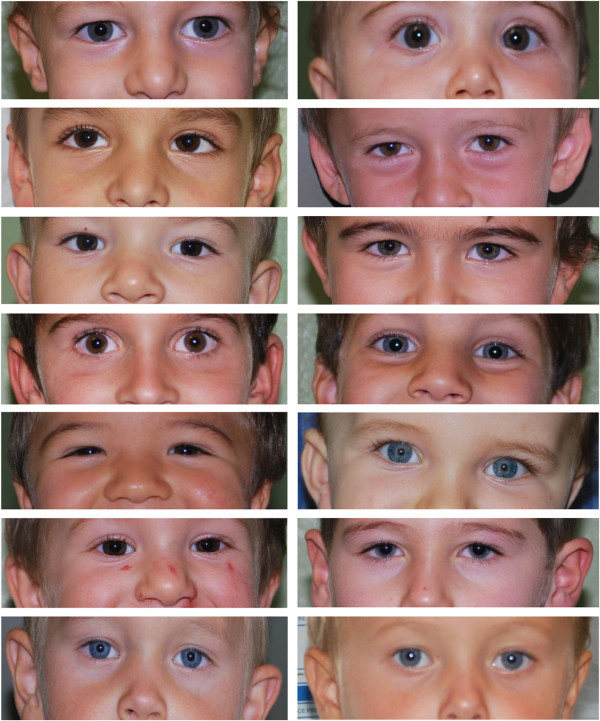
Facial features. Orbital and malar region of 47,XYY probands showing mild hypertelorism, broad nasal bridge and mild flat malar region. A and B Couple of dizygotic males twins. One with 47,XYY prenatal diagnosis.